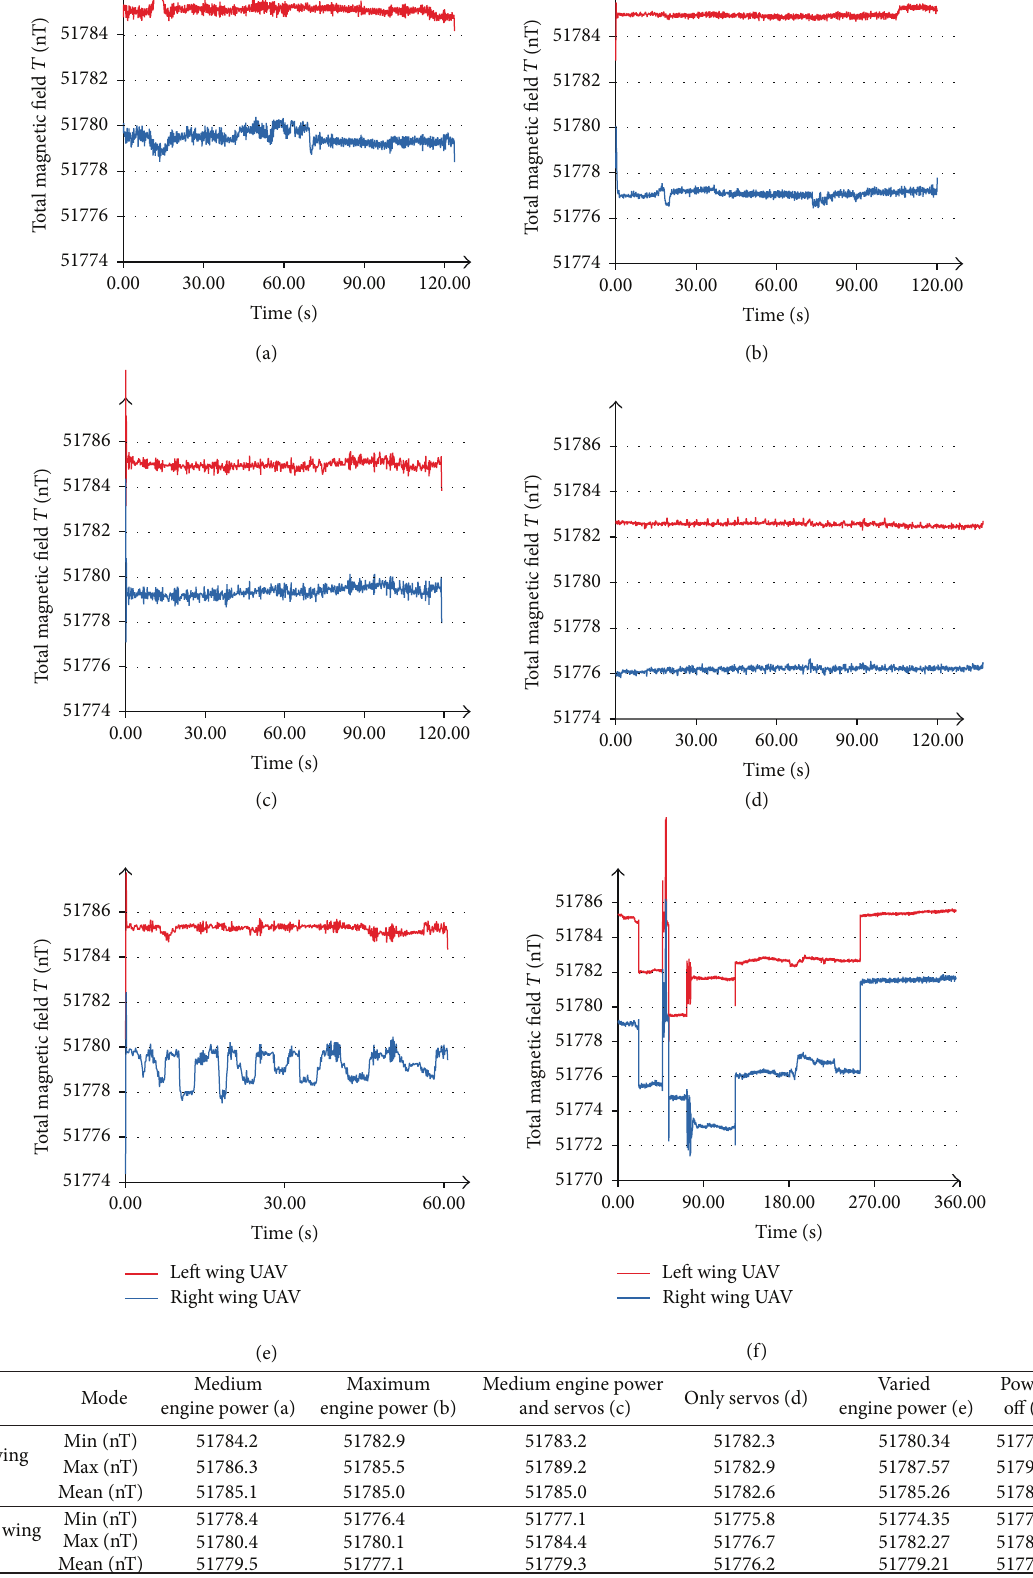
Figure 5: Magnetic field at the ends of UAV’s wings at different modes: (a) medium engine power; (b) maximum engine power; (c) medium engine power and servos; (d) only sensors; (e) varied engine power; (f) power